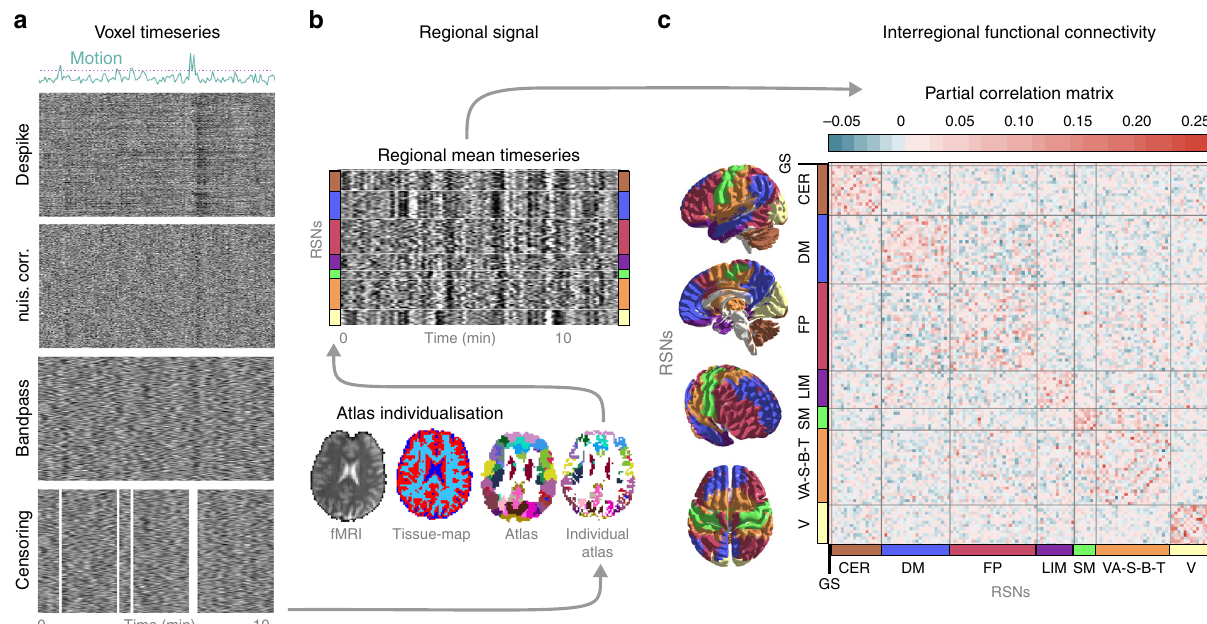
Fig. 1 Calculating functional brain connectivity from resting-state fMRI measurements. Raw brain images of N = 116 participants, in total, underwent automated artefact removal, involving despiking, nuisance regression, bandpass fi ltering and censoring of motion-contaminated time-frames. The effects of these procedures on the BOLD signal are exempli fi ed on the carpet-plots ( a , x: time, y: voxel, colour: intensity). Subsequently, a multi-stage, high-precision brain atlas individualisation was performed to obtain regional grey-matter signals for M = 122 functionally de fi ned brain regions ( b ). Partial correlation between all possible region pairs was computed to asses functional connectivity and ordered based on large-scale modularity to form individual connectivity matrices. Partial correlations of all regions with the global grey-matter signal was retained to account for, but not completely discard the effect of the global signal, a component of brain activity often regarded as a confound but also related to e.g. vigilance 83 . c Subject-level connectivity matrices (depicted by the group-mean connectivity matrix) from Study 1 served as an input for machine-learning-based prediction of behavioural pain